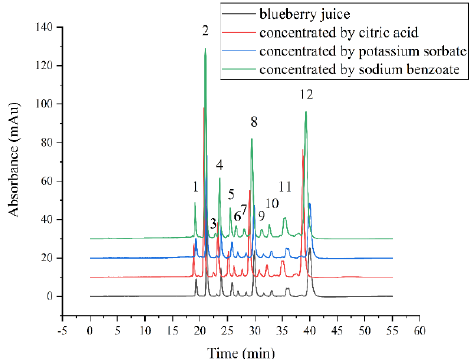
Membranes 2022 , 12 , x FOR PEER REVIEW 8 of 12 Figure 4. Size distribution of original and concentrated blueberry juices. 3.2.3. Effects on the Anthocyanins Profile Twelve anthocyanins were identified in blueberry juice, as reported in our previous study [47]. As shown in Figure 5, all peaks persisted steadily after concentrations, indicating that it made a slim difference to anthocyanins in blueberry juice during FO processes. Varied anthocyanins have different polarities due to different glycosides and